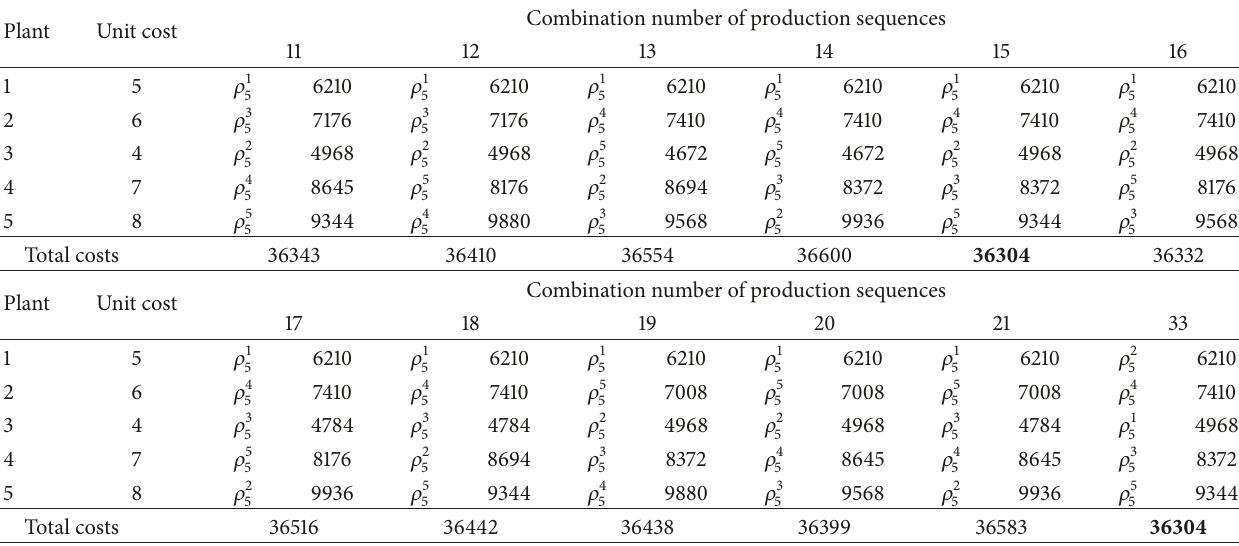
Table 7: Manufacturing costs in the five-plant system (chosen